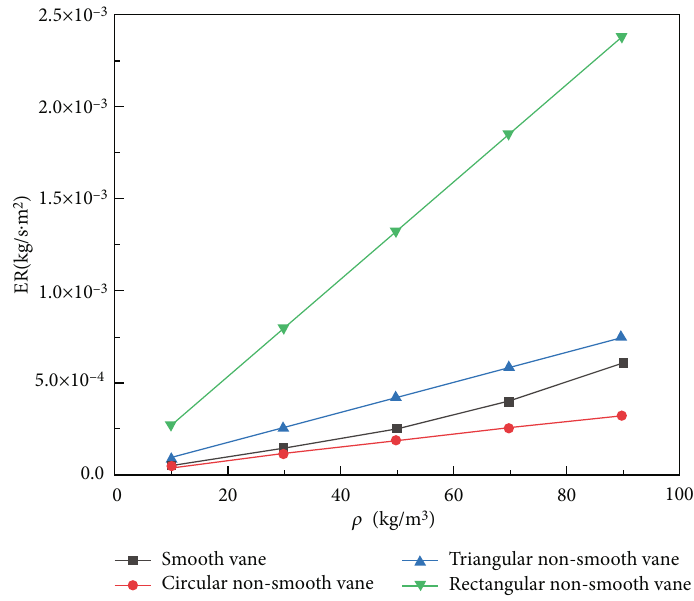
Figure 10: Average wear rate particle concentration curve of double-vane pump vanes with di ff erent structured